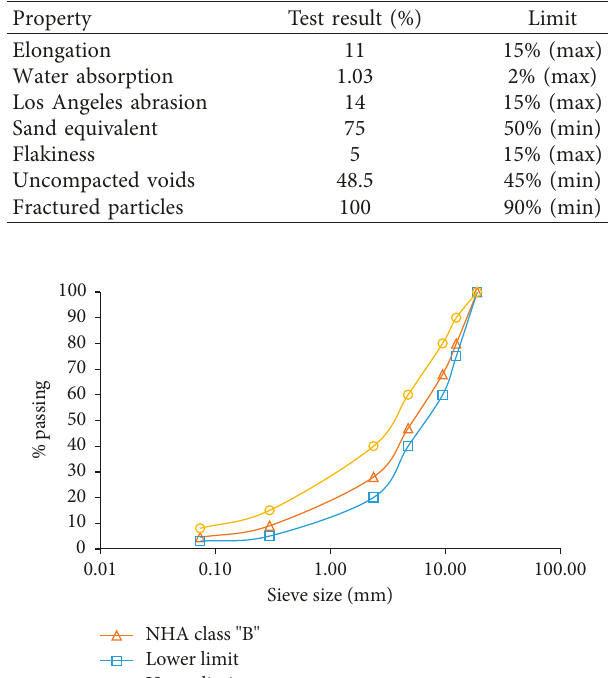
Table 2: Physical properties of aggregates [28].